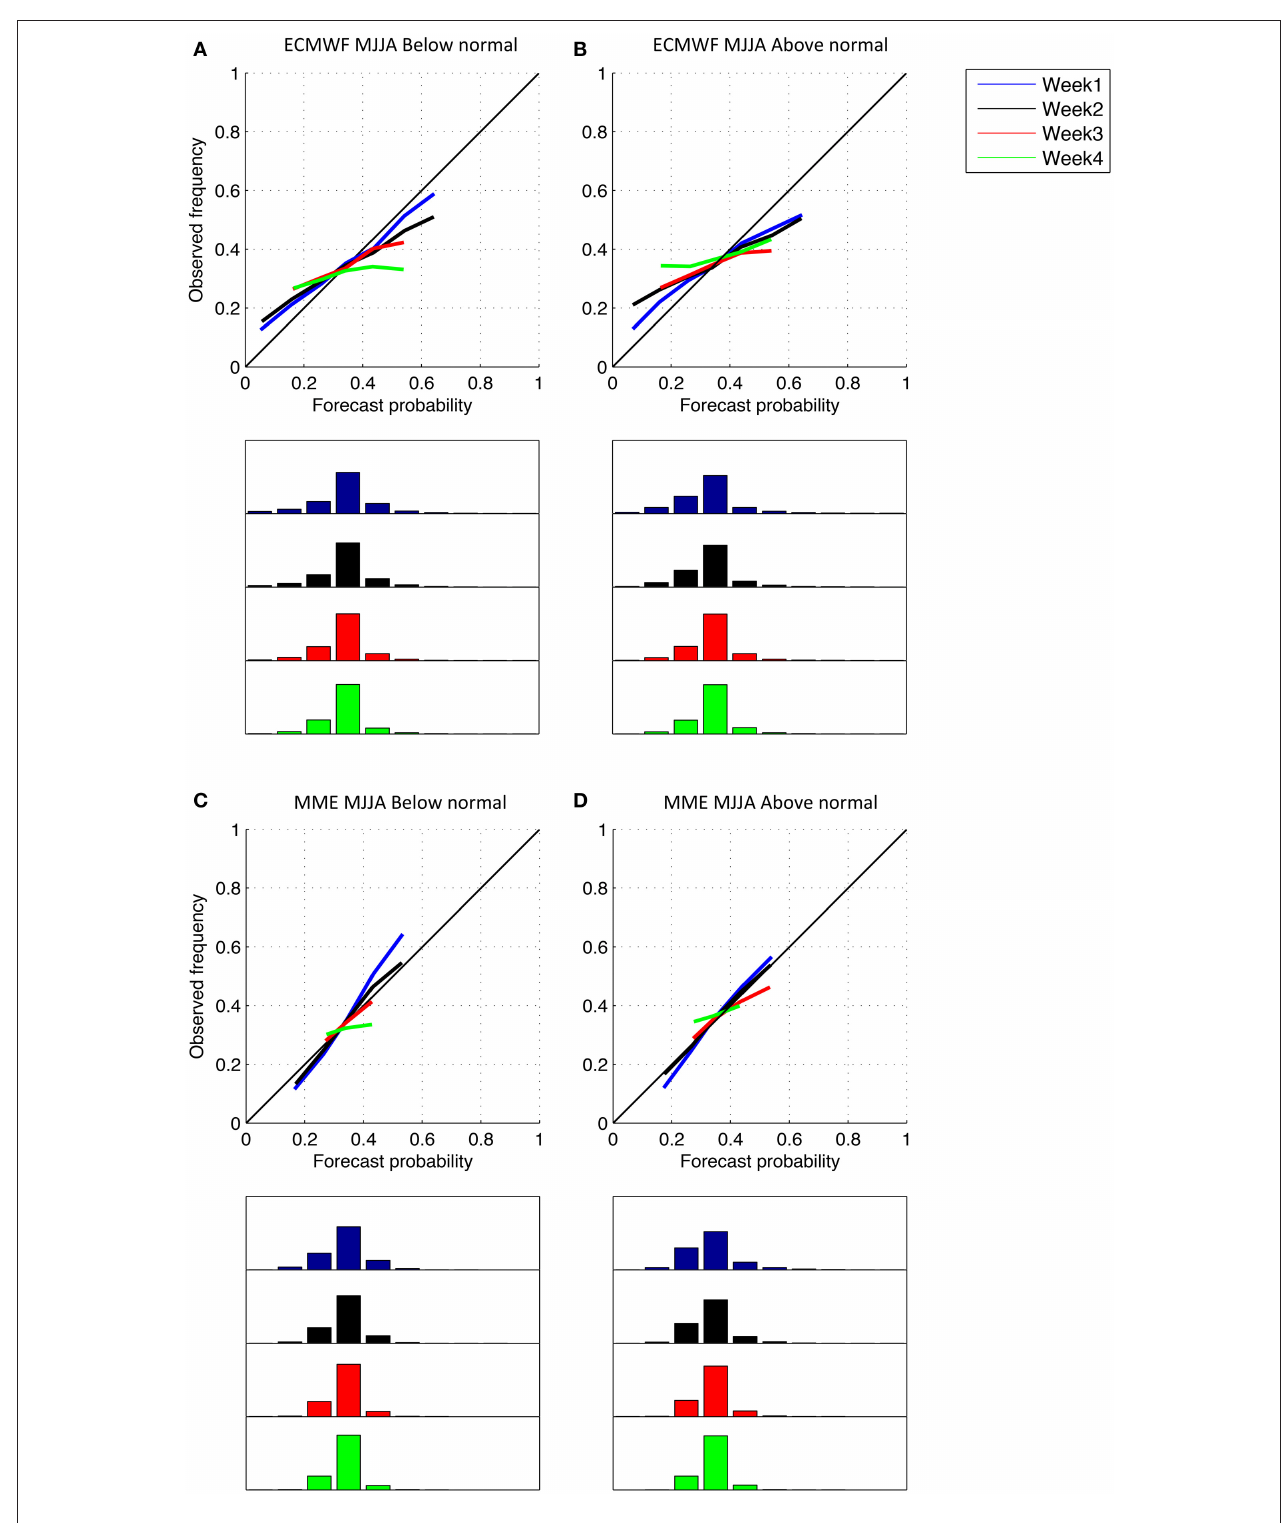
FIGURE 3 | Similar to Figure 2 but for landpoints of the West African monsoon region shown in Figure 6 .